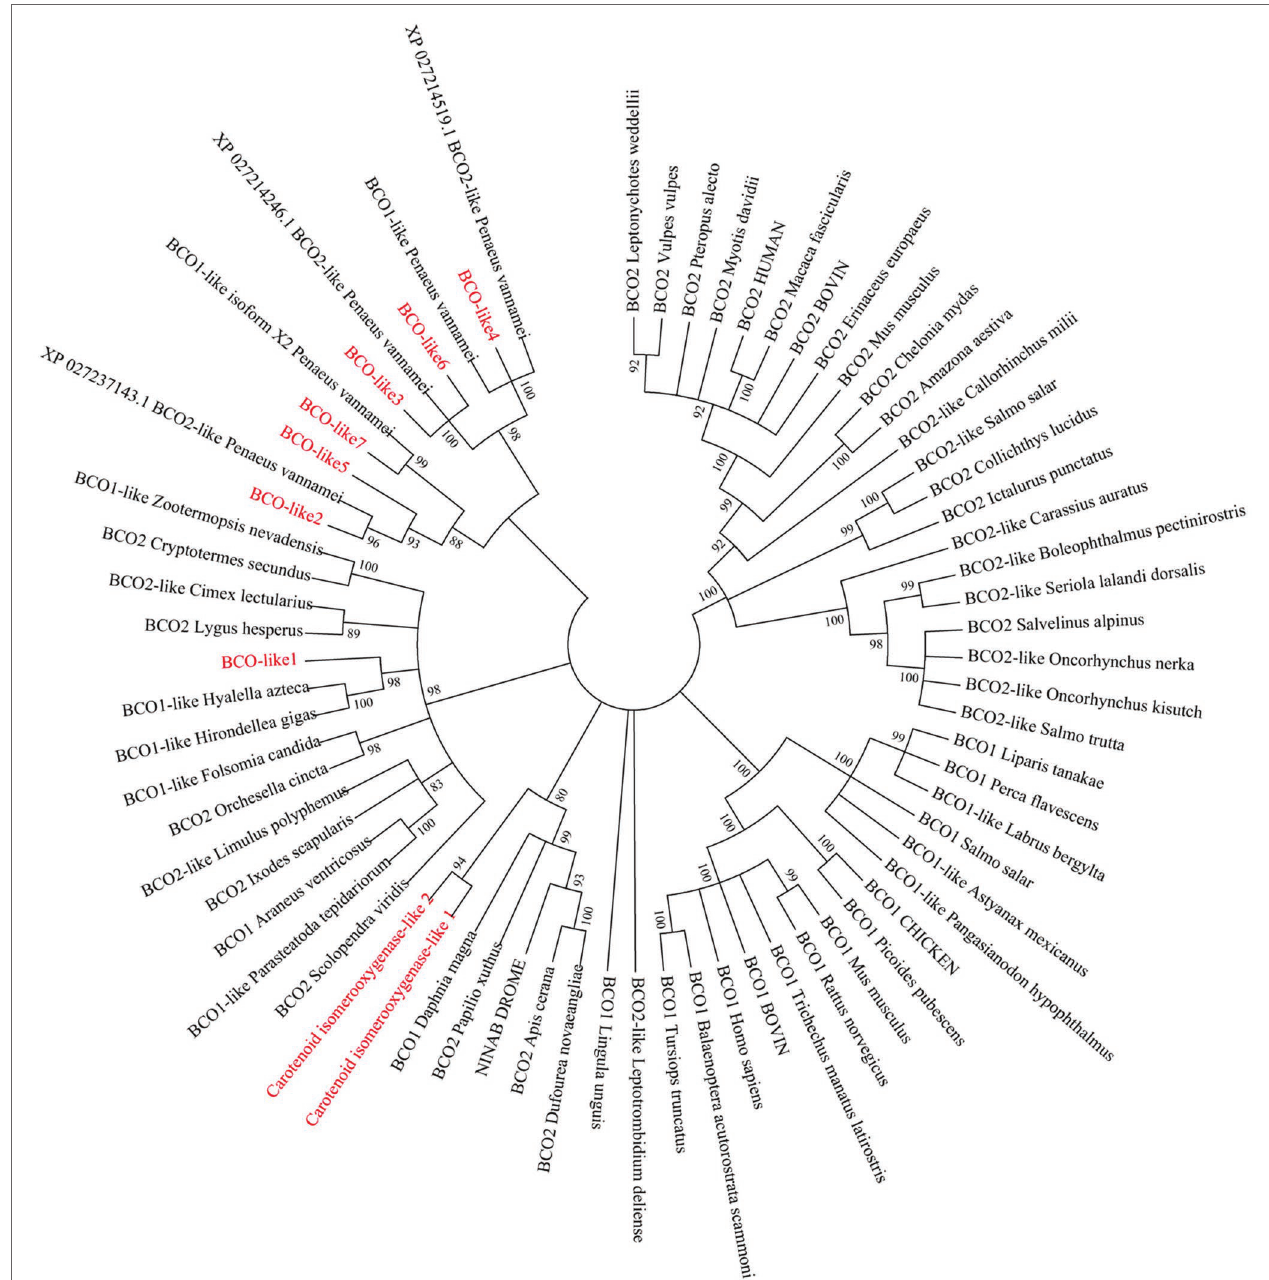
FIGURE 2 | Evolutionary relationships of carotenoid oxygenases from Exopalaemon carinicauda and other species. The phylogenetic tree was constructed by the Neighbor-Joining distance algorithm, and bootstrap value was set at 1,000. All the EcBCO-like genes and two carotenoid isomerooxygenase like genes in the tree are marked with red